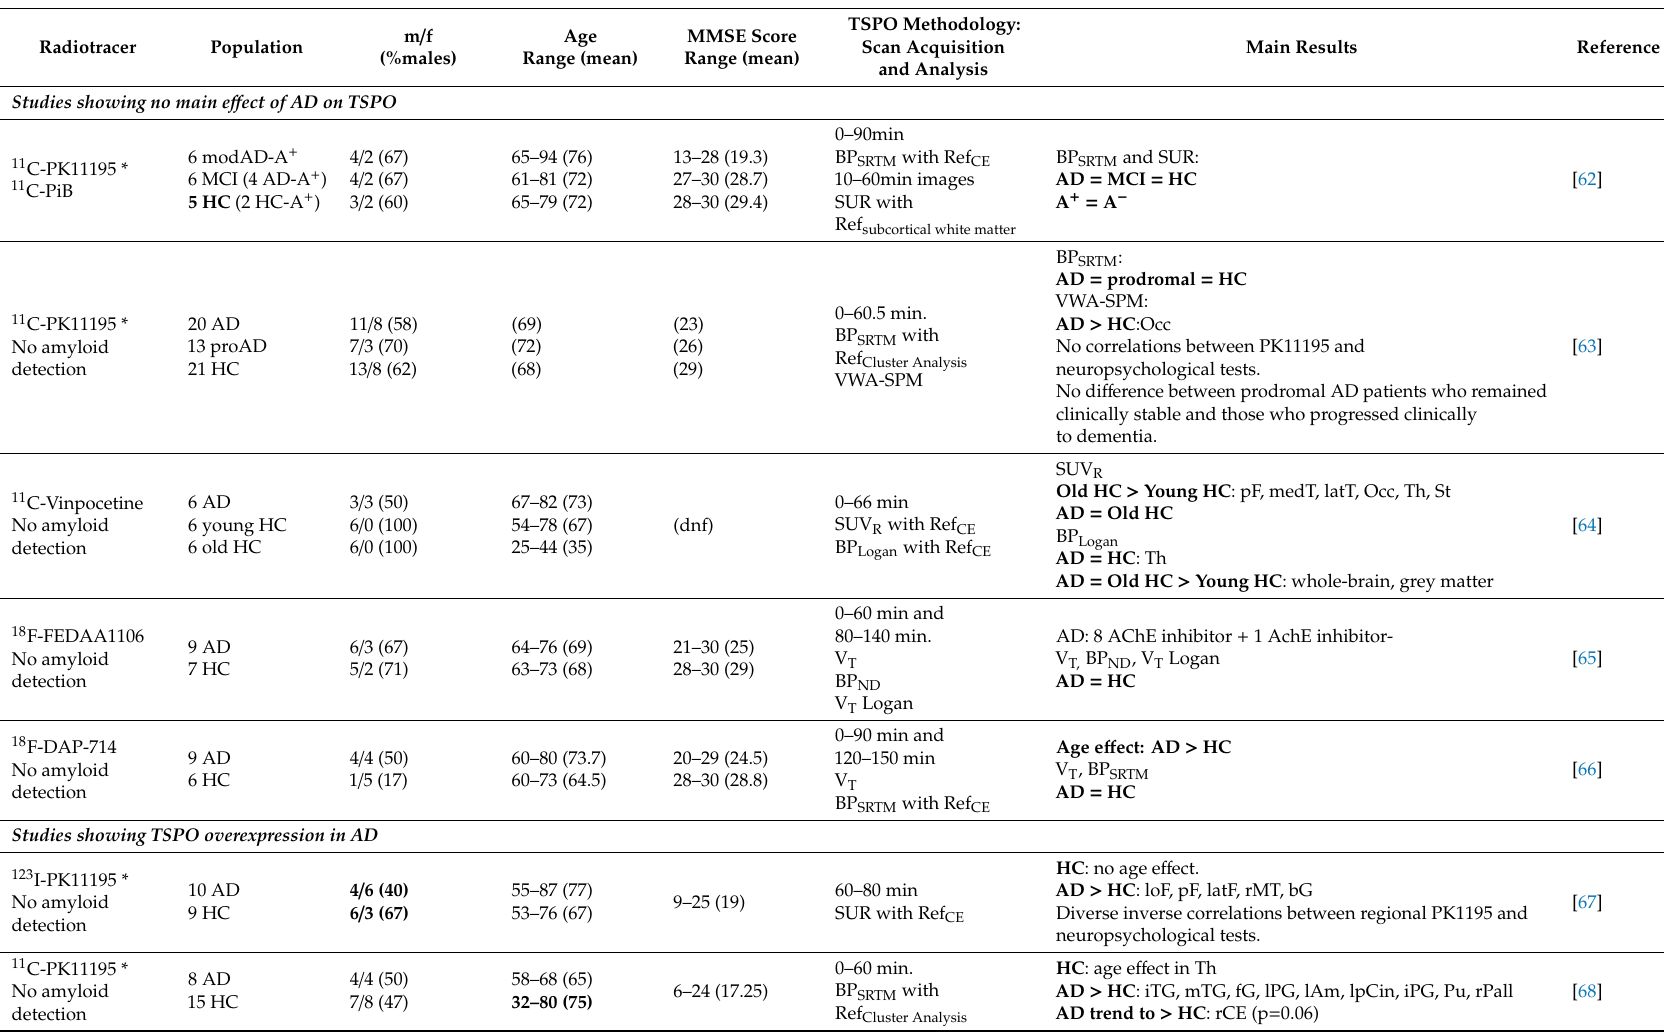
Table 1. Main results of TSPO positron emission tomography (PET) / single-photon emission computed tomography (SPECT) studies in Alzheimer’s